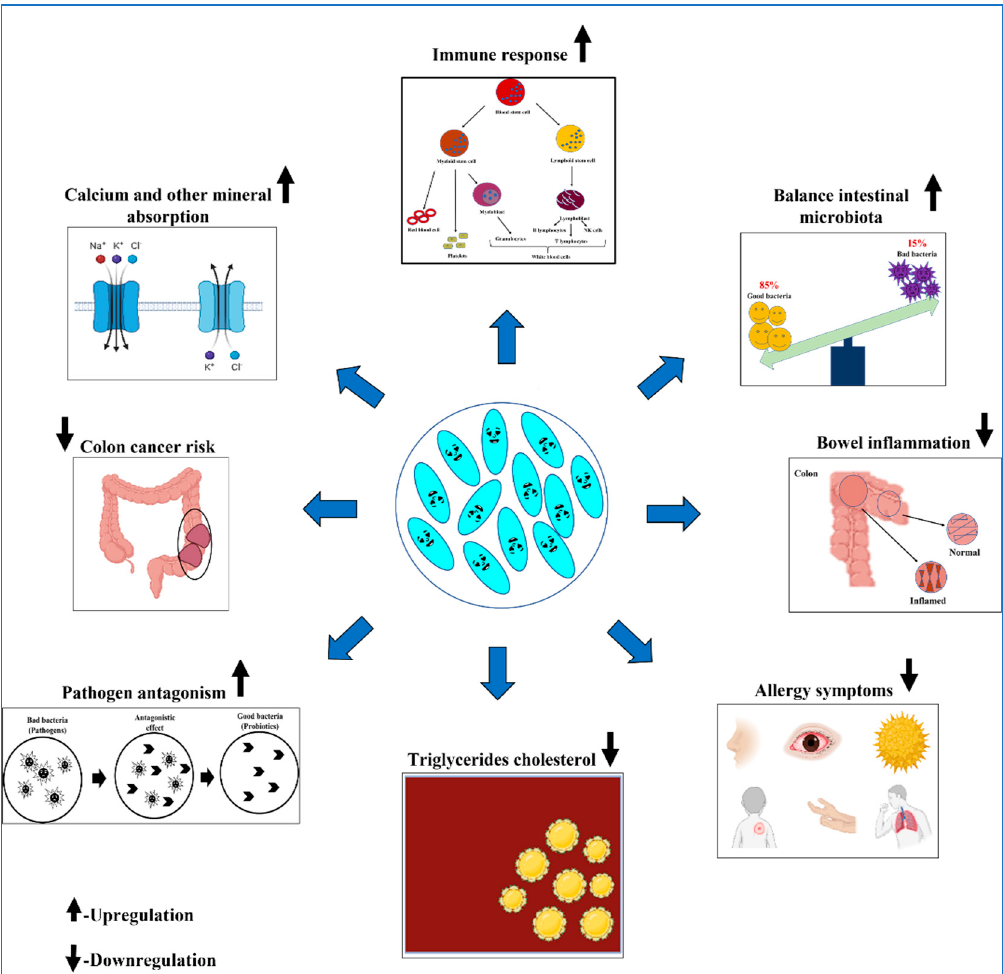
Figure 1. Proposed modes of action of probiotics.